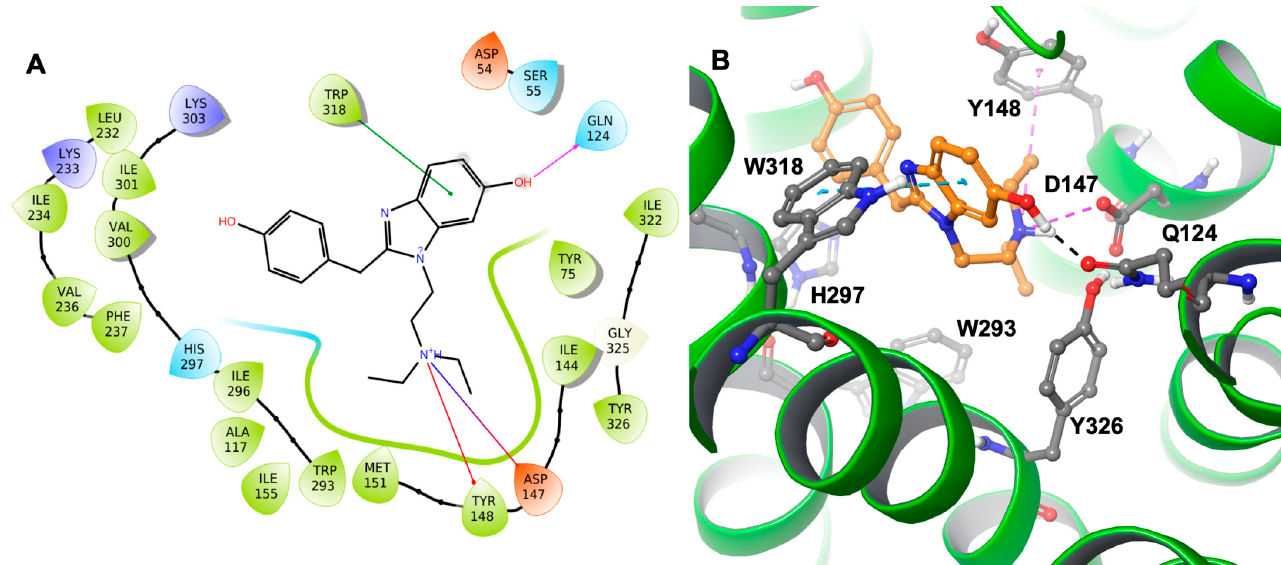
Figure 4. ( A ) The two-dimensional (2D) and ( B ) three-dimensional (3D) interaction diagram of the M6 metabolite with MOR. The key residues are shown in the ball and stick model (carbon in gray), and transmembrane regions are shown as ribbons (green-colored). M6 is shown in the ball and stick model (carbon in orange). The distance between W318 and benzimidazole moiety (edge to face; π – π stacking) is 4.7 Å. The H-bond, salt bridge, and cation– π distances are 1.85 Å, 3.09 Å, and 5.97 Å, respectively. Table 2. Physicochemical properties of etazene and its metabolites calculated using the ADMET